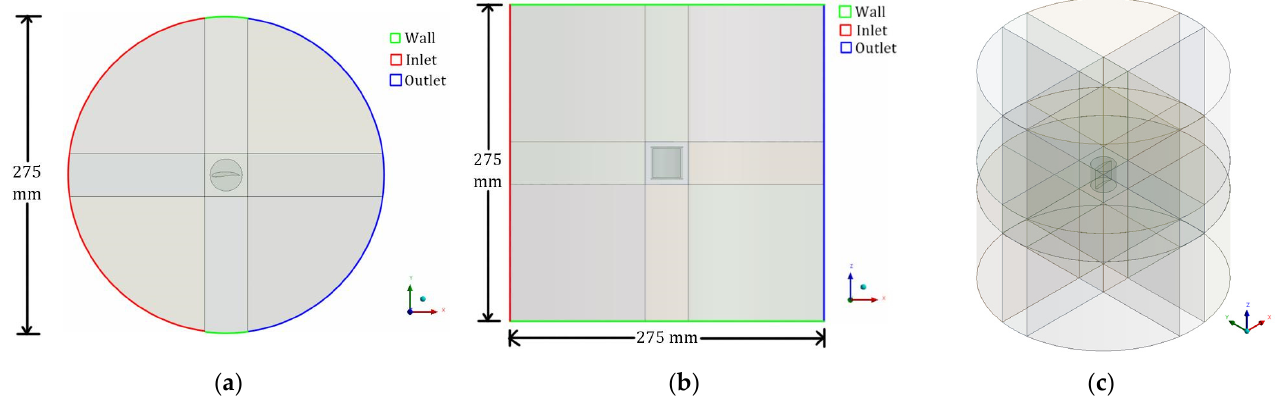
Figure 1. Single blade geometry: ( a ) Viewed from above; ( b ) Viewed from side; ( c ) Isometric view. The mesh uses the multizone meshing method, with hexahedron-mapped meshes and tetrahedron-free meshes to allow zones to be assigned different mapping styles. Ad- ditionally, body sizing and inflation have been used to make the mesh denser around the aerofoil. Three mesh sizes were created: 1 million elements, 0.5 million elements, and 1.4 million